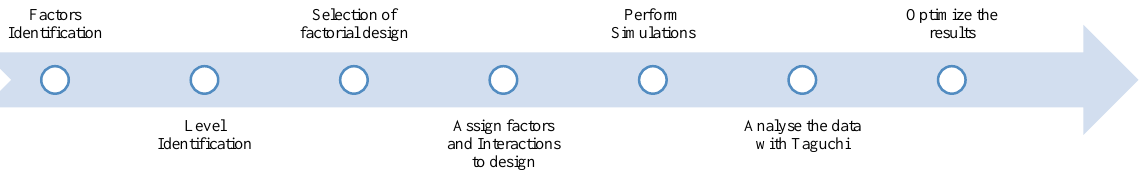
Figure 3. Steps in implementation of the Taguchi approach.